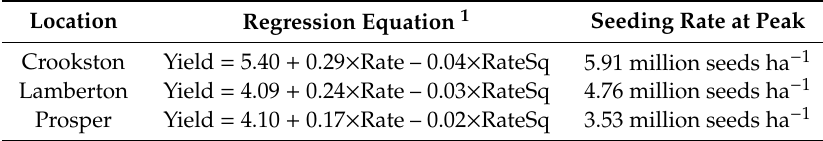
Table5. Regressionsummaryofyieldresponsetoseedingrateoverthesixlowest-yieldingenvironments in Minnesota and North Dakota,